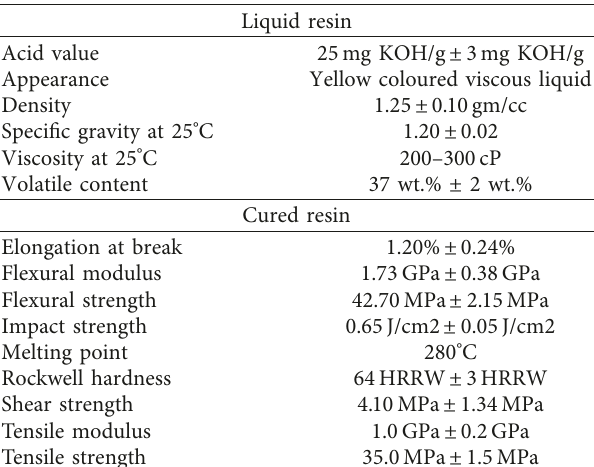
Figure 1: Photographs of (a) Furcraea selloa K Koch plant with peduncle; (b) Peduncle under microbial degradation process; (c) Extracted fibers; and (d) FSPF reinforced composite at different weight percentages. Table 2: Properties of liquid and cured polyester resin utilized to prepare